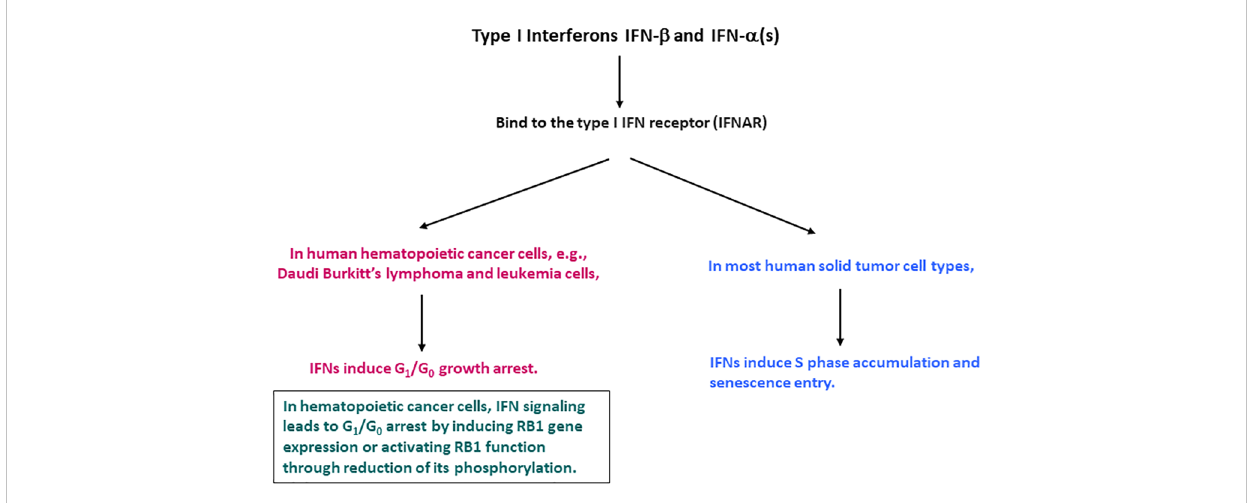
FIGURE 1 Cell cycle alterations induced by IFN- b and IFN- a in human hematopoietic cancer and solid tumor